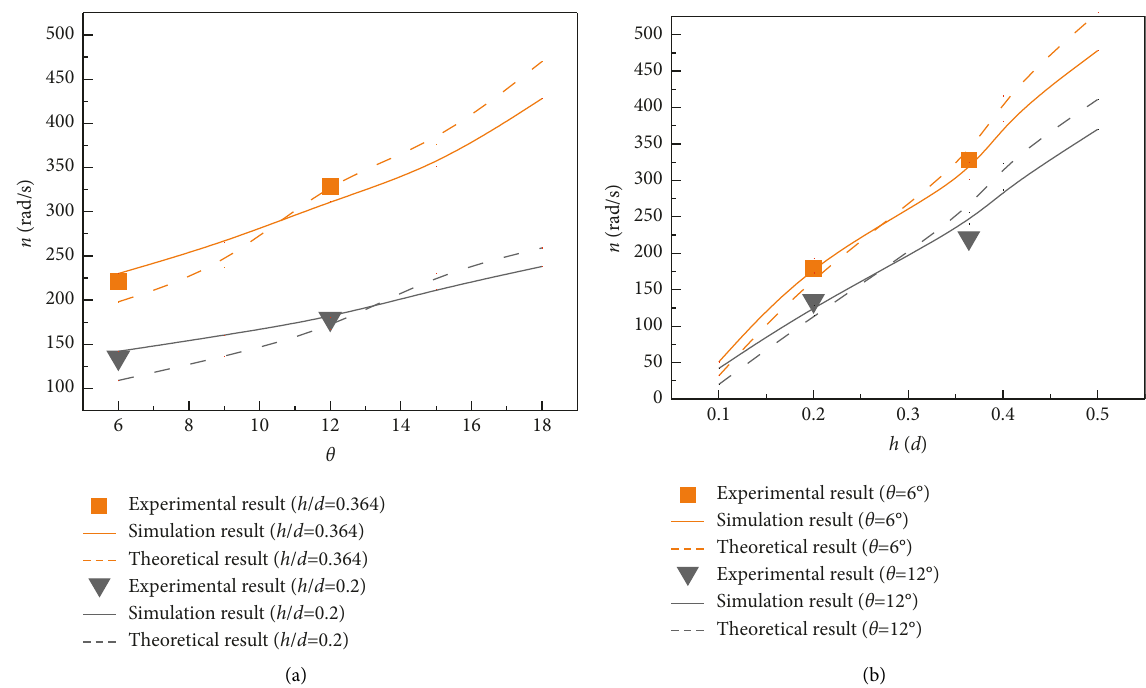
Figure 16: Comparison between experimental and numerical simulation results. (a) Variations of the initial angular velocity with the step depth. (b) Variations of the initial angular velocity with the step